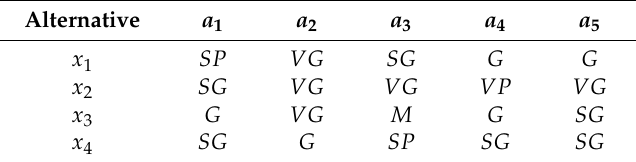
(cid:16) (cid:17) s r ij 3 4 × 5